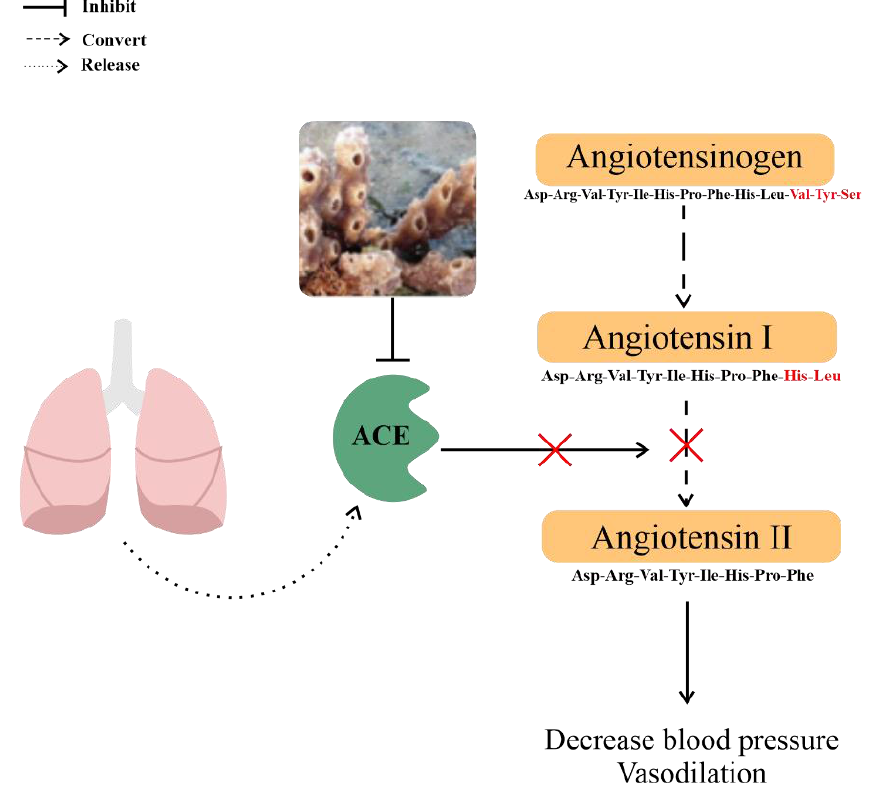
Figure 5. Antihypertensive mechanism of Callyspongia diffusa .